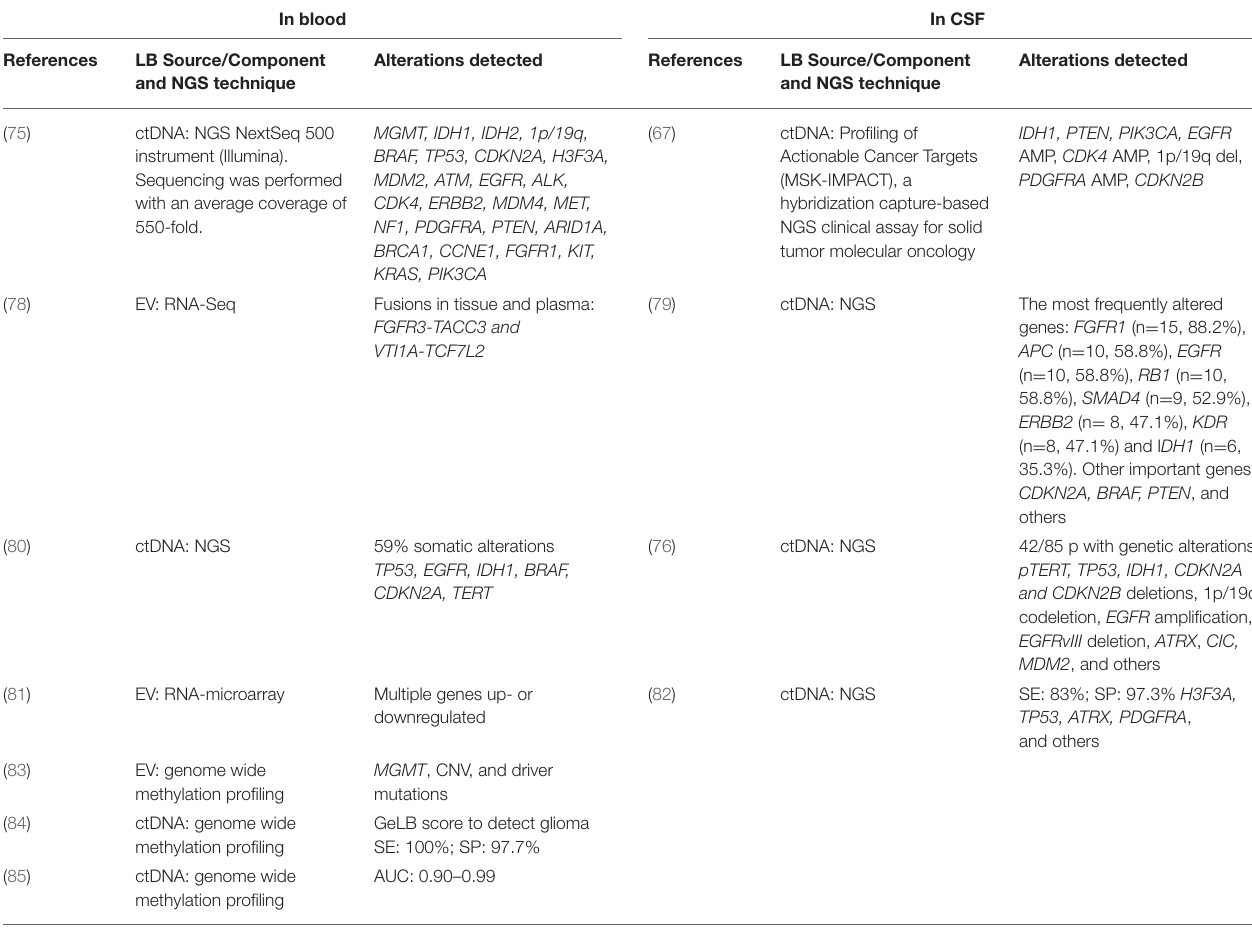
TABLE 3 | Alterations detected in liquid biopsy by next-generation sequencing